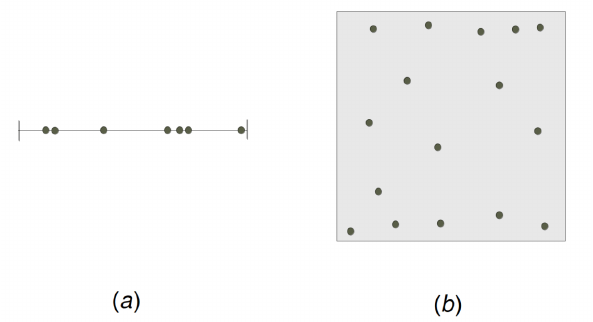
Figure 2. ( a ) Random sensors on the unit interval. ( b ) Random sensors on the unit